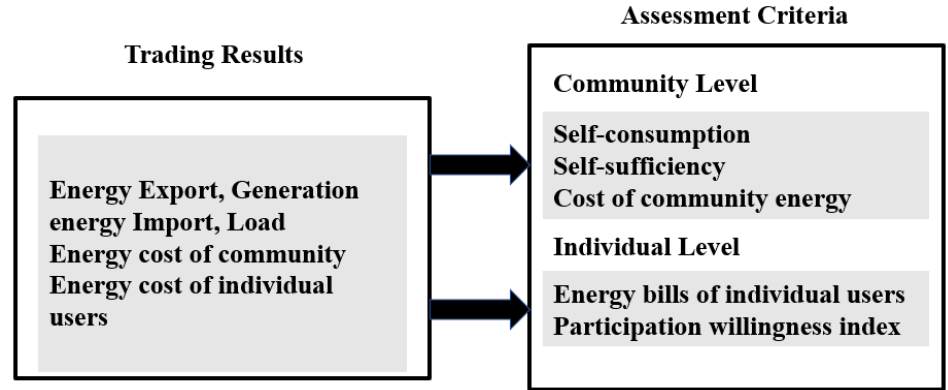
Figure 5. Two levels of model assessment.